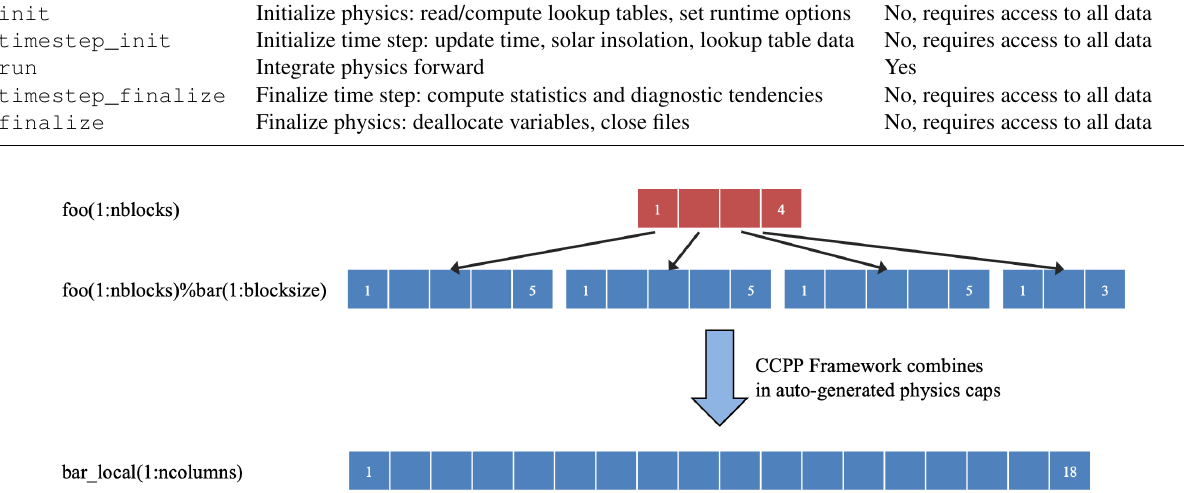
Figure 2. The CCPP Framework automatically combines blocked data structures into contiguous arrays during certain phases of the physics calls, as shown here for the variable bar that is part of derived data type foo , which is split up into four